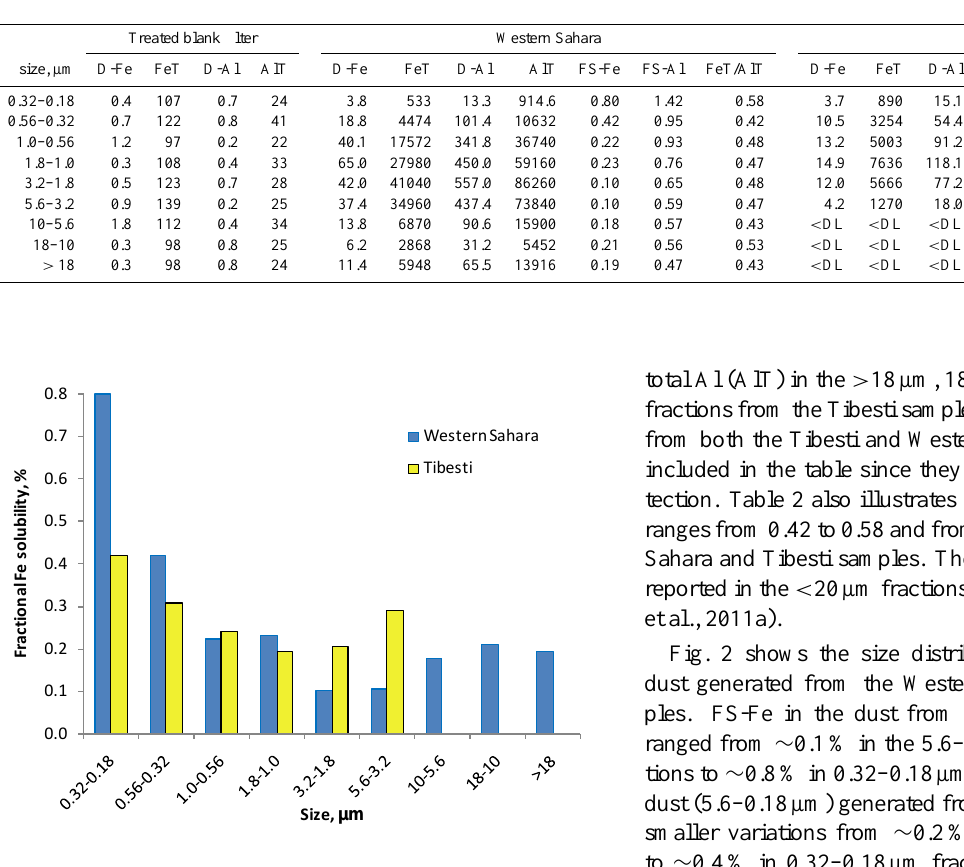
Fig. 2 Fractional Fe solubility (FS-Fe) of size-fractionated dust generated from the Fig. 2. Fractional Fe solubility (FS-Fe) of size-fractionated dust Western Sahara and Tibesti samples. generated from the Western Sahara and Tibesti